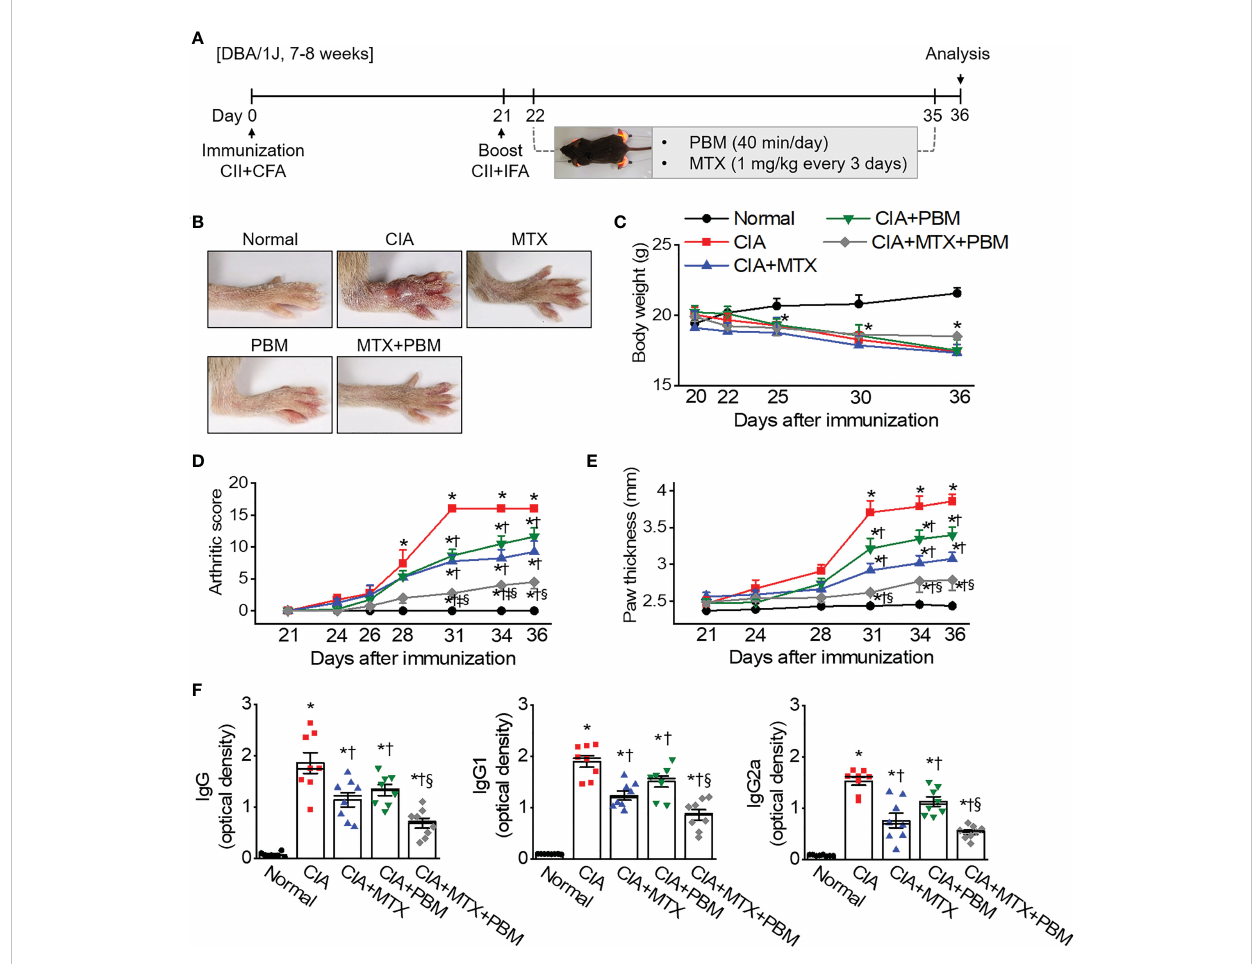
FIGURE 2 PBM alleviates the clinical symptoms of collagen-induced arthritis (CIA) in DBA/1J mice. (A) Production of CIA mouse model. Schematic representation of experimental procedure. Mice were immunized on Day 0 with intradermal injection of 100 m g of bovine type II collagen (CII) emulsi fi ed with an equal volume of complete Freund ’ s adjuvant (CFA). Immunization was boosted by an equal volume of emulsion of CII and incomplete Freund ’ s adjuvant (IFA) on Day 21. At the time of CII injection, normal mice were immunized and boosted with PBS. Methotrexate (MTX) as a positive control was administered intraperitoneally once every 3 days from day 22 to day 35. Light stimulation with 10 mW/cm 2 was applied to the ankle joints via direct contact with the skin for 40 min daily from day 21 to day 35. Animal experiments were performed in triplicate. (B) Gross observation of the hind paw; photographs are representative of each group on Day 36. (C) Body weight was measured on the indicated days after the primary immunization. (D) Mean arthritic score for each group. The severity was evaluated on a scale from 0 to 4. The scores of all four paws were summed to obtain the arthritis score. (E) Paw thickness was measured using an electric caliper by three researchers independently. (F) Collagen-speci fi c antibodies in the mouse sera were measured using the enzyme-linked immunosorbent (ELISA). Data are shown as mean ± SE ( n = 7 − 8). * p < 0.05, compared to Normal. † p < 0.05, compared to CIA. ‡ p < 0.05, compared to CIA+MTX. § p < 0.05, compared to